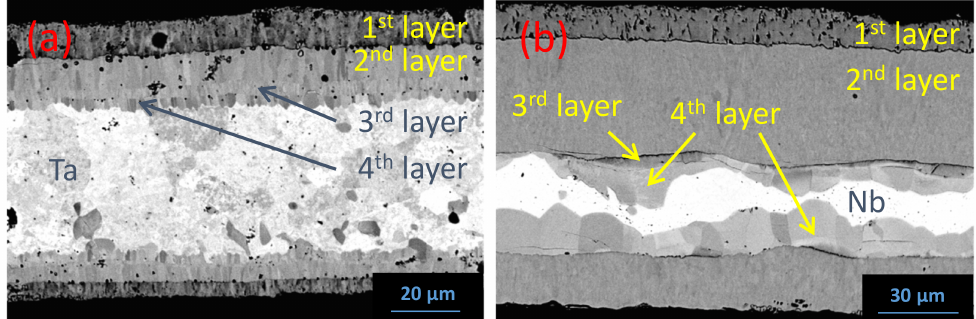
Figure 8. BSE-SEM micrographs of the reaction zone after 1000 h at 1200 ◦ C in the ( a ) Nb–SiC/SiC and ( b ) Ta–SiC/SiC sandwich